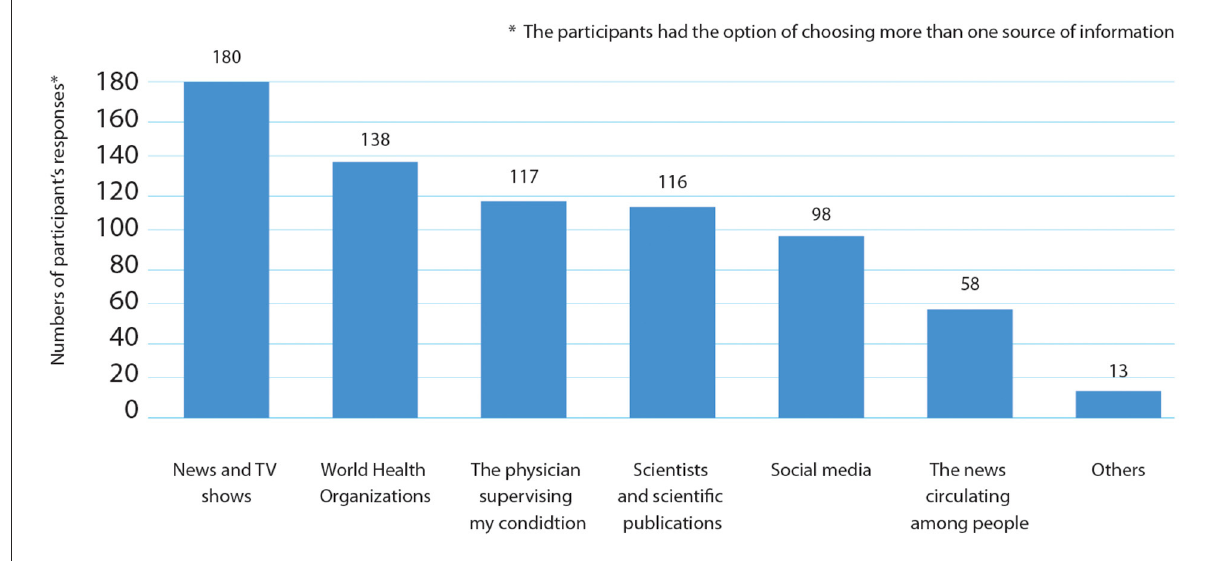
FIGURE3 Personal stated sources of information about SARS-CoV-2) vaccines declared by cancer patients.